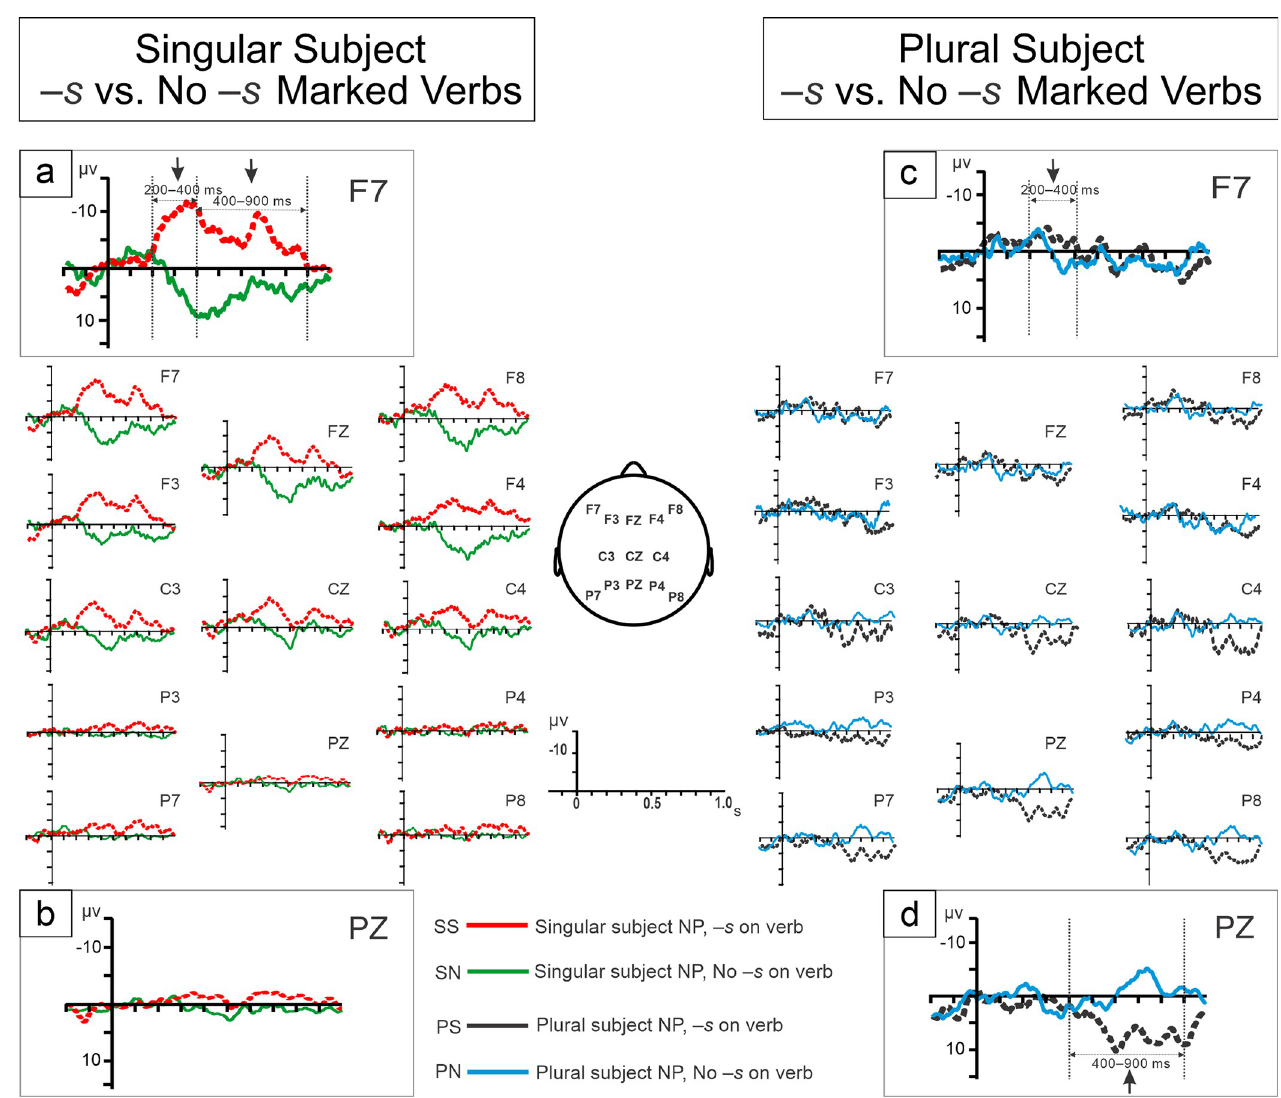
Fig 4. Grand average ERPs for the four experimental conditions. ERPs were time-locked to the onset of the target position, i.e., at the right edge of the underlined word in Table 1. Negativity is plotted upwards. Left plot (SS vs. SN): Compared to AAE grammatical sentences that pair a singular NP subject with a suffix-less verb (green), AAE ungrammatical sentences with singular NP subjects and– s marked verbs (red) showed a bilateral anterior-central negativity in both the 200–400 ms and 400–900 ms time windows (Zoom-in plots (a) and (b)). Right plot (PS vs. PN): Compared to AAE grammatical sentences that pair a plural subject NP with a suffix-less verb (blue), AAE ungrammatical sentences with plural subject NPs and– s marked verbs (black) showed a bilateral anterior negativity (200–400 ms), followed by a bilateral central-posterior positivity (400–900 ms) (Zoom-in plots (c) and